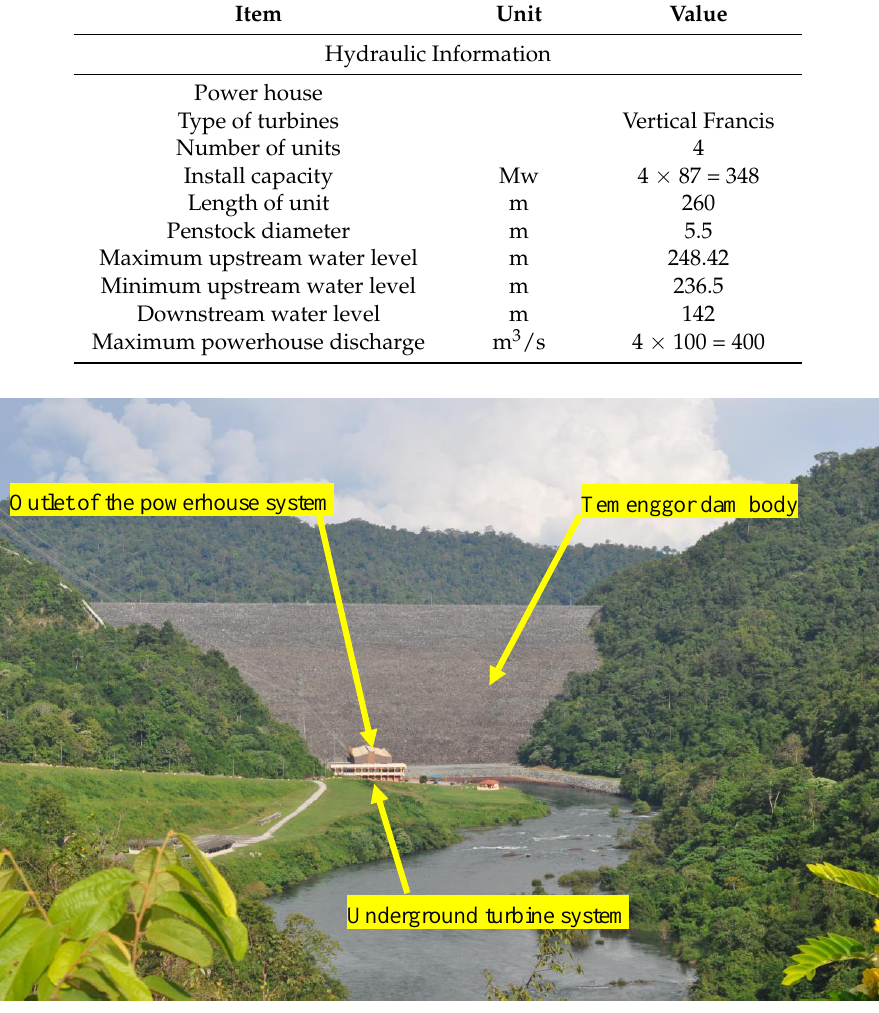
Figure 2. Downstream of Temenggor dam with outlet of the power-station.